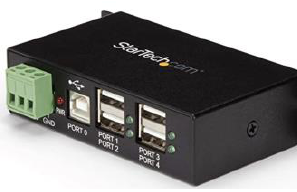
Figure 9. StarTech.com port hub.